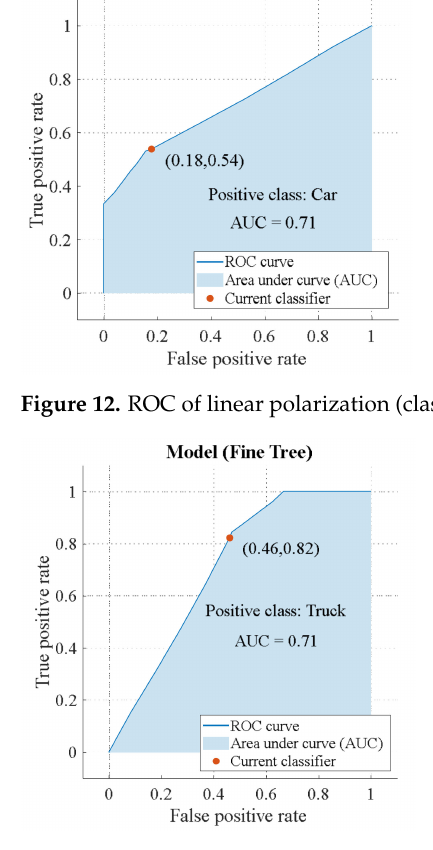
Figure 13. ROC of linear polarization (class